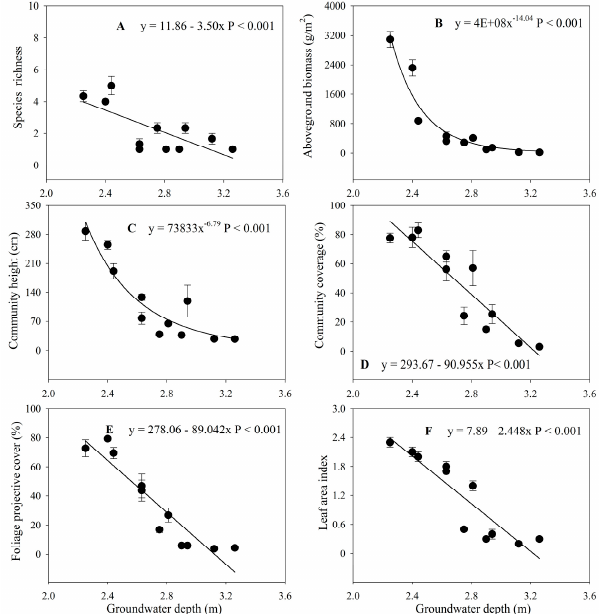
Figure 3. Relationship between community characteristics and groundwater depth. ( A ) Species richness; ( B ) Aboveground biomass (g/m 2 ); ( C ) Community height (cm); ( D ) Community coverage (%); ( E ) Foliage projective cover (%); ( F ) Leaf area index.